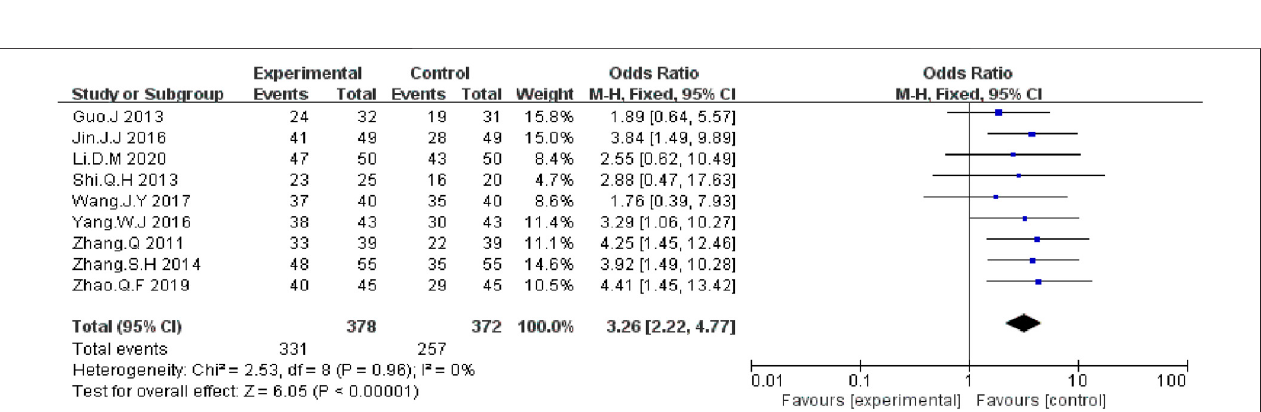
Frontiers in Pharmacology |